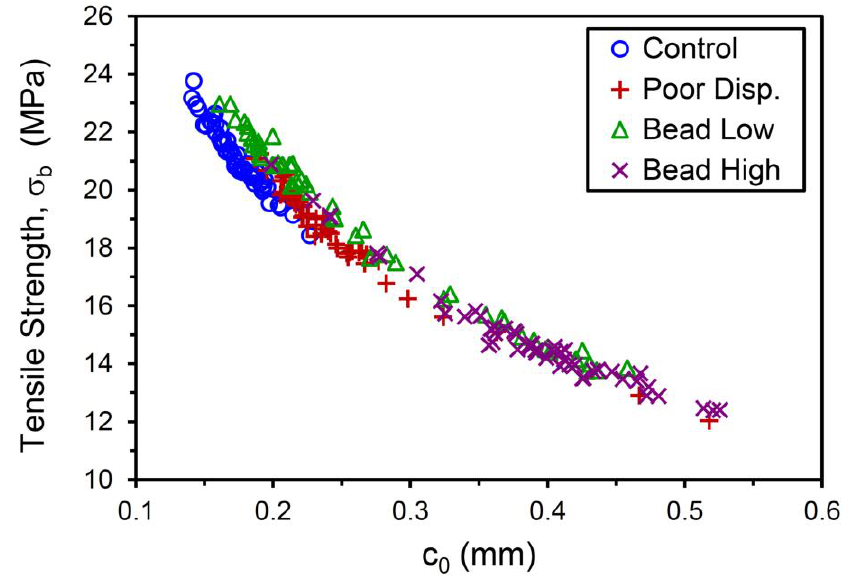
Figure 10. Tensile strength versus crack precursor size for the four compounds.